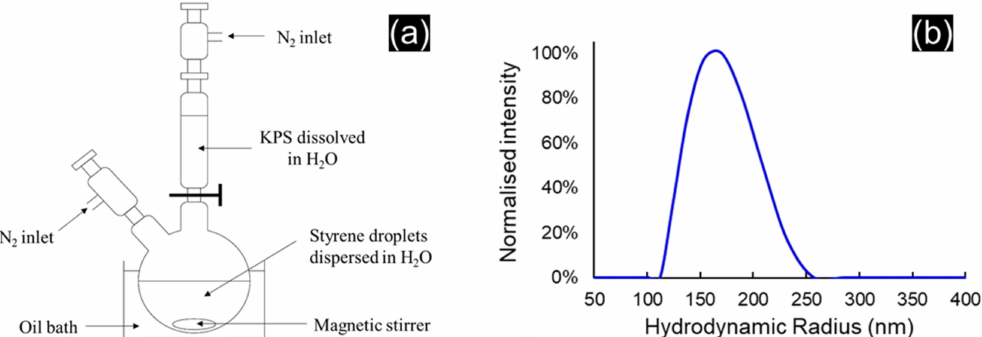
Figure 1. ( a ) Schematic illustration of the apparatus used to produce the PS beads by surfactant‑free emulsion polymerization and ( b ) distribution of hydrodynamic radius obtained with dynamic light scattering.